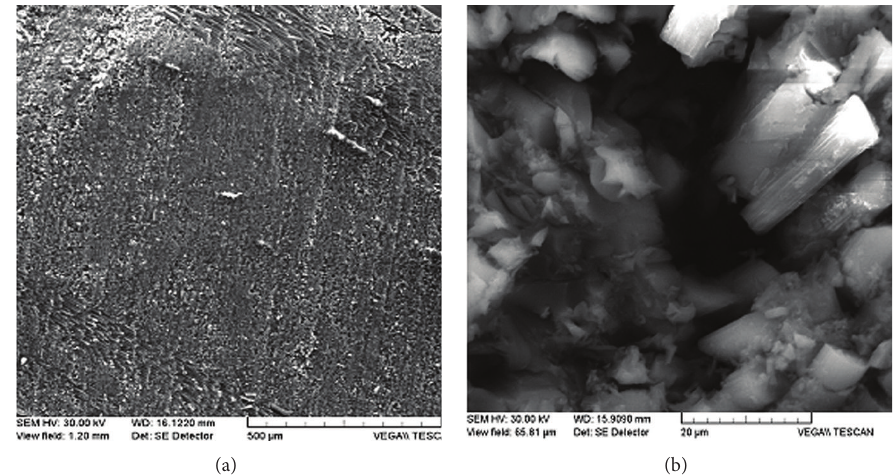
Figure 10: (a) The entire thickness cross-section of a sample manufactured at 70psi. (b) Even smaller and less voids formed at 70 psi